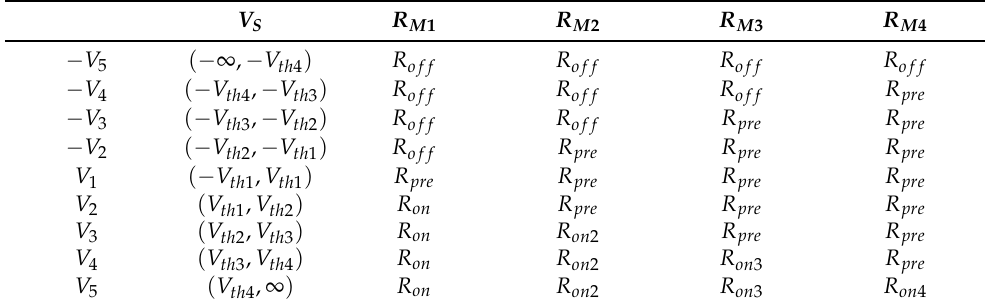
Table 2. The relationship between the resistance values of M 1 , M 2 , M 3 , and M 4 and the voltage